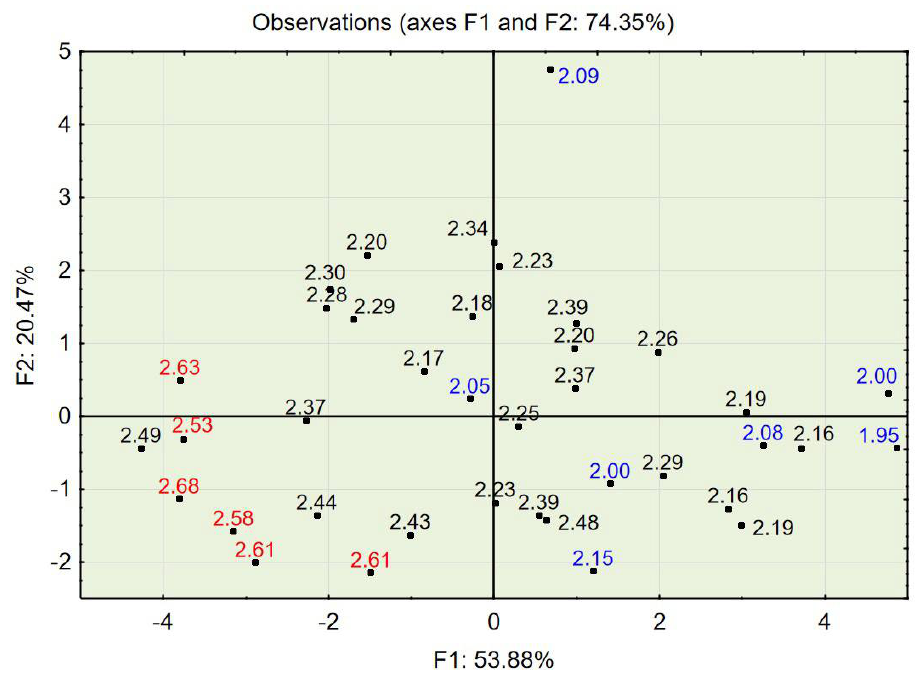
Figure 7. PCA with object grouping in a two-dimensional space on the basis of concrete composition in relation to concrete properties. Splitting tensile strength: red represents a strength over 2.5 MPa, and blue represents a strength below 2.10 MPa.